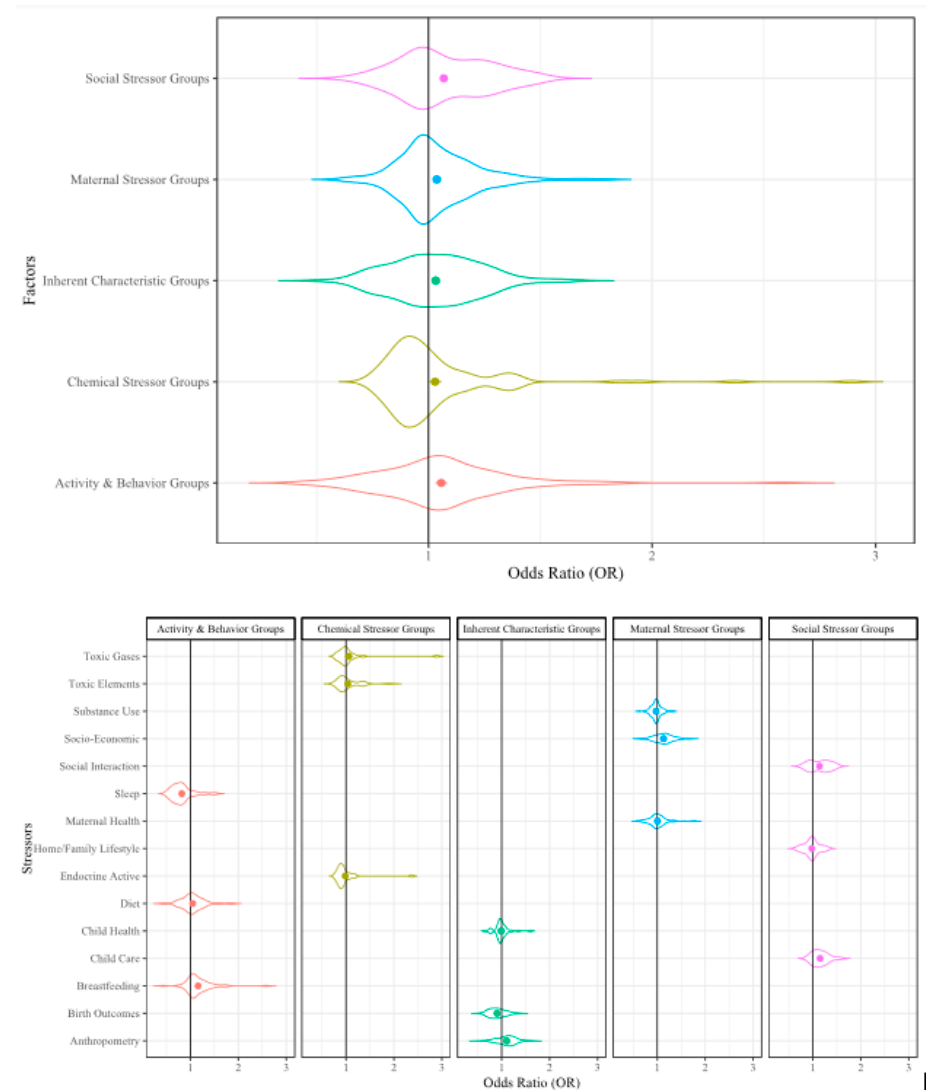
Figure 6. Violin plot of all factors that may influence cognitive development. Violin width represents the distribution of the Odds Ratios (OR), the height represents density of the ORs; dots represent mean OR, error bars represent mean SE.